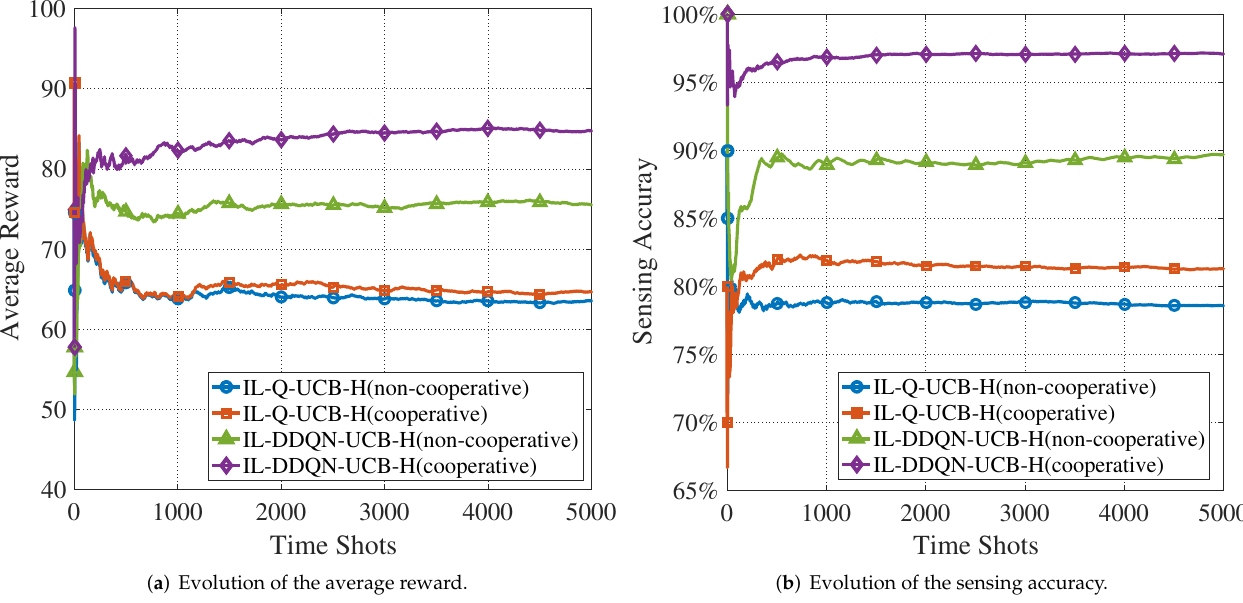
Figure 8. Evolution of the average reward and the sensing accuracy of the proposed algorithms in cooperative and non-cooperative scenarios ( N = 10, M =